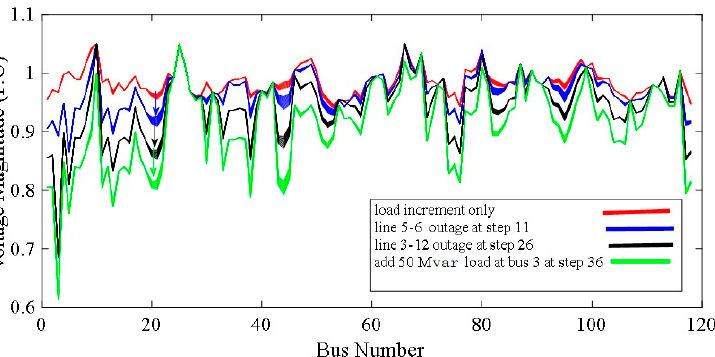
Figure 20. The amplitude of the voltage profile in the events leading to the voltage collapse point for the IEEE 118-bus test system.